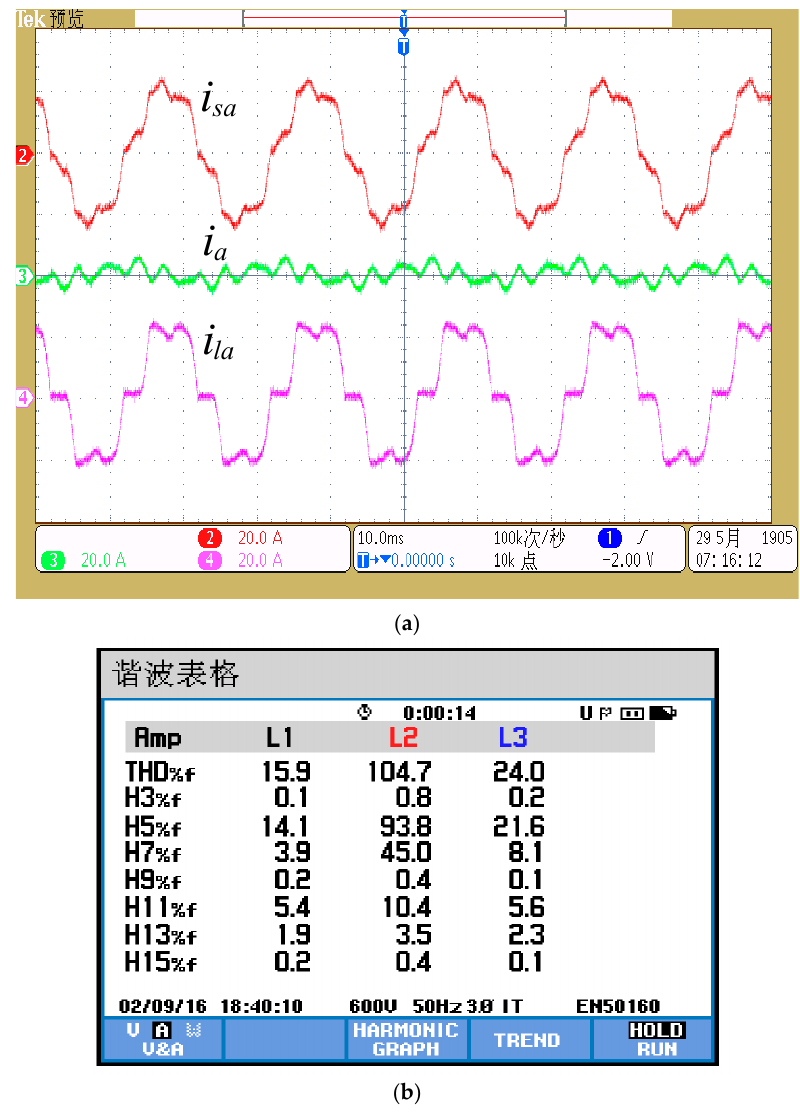
Figure 13. Harmonic compensation results by only the LC filter: ( a ) Source (L1), compensating (L2), load (L3) current waveforms; ( b ) Harmonic distortion rate graph.